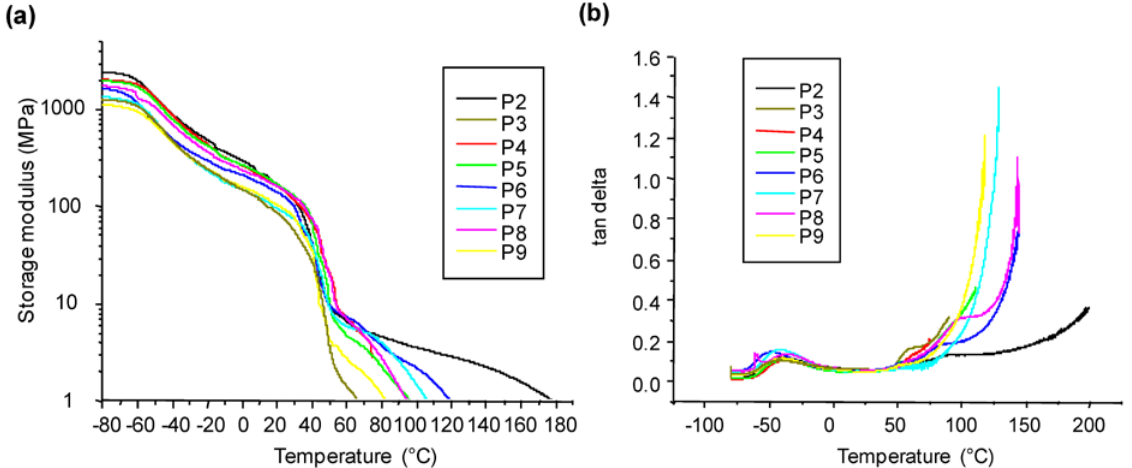
Figure 3. Plot of (a) the storage modulus and (b) tan δ as a function of temperature for polymers P2 – P9